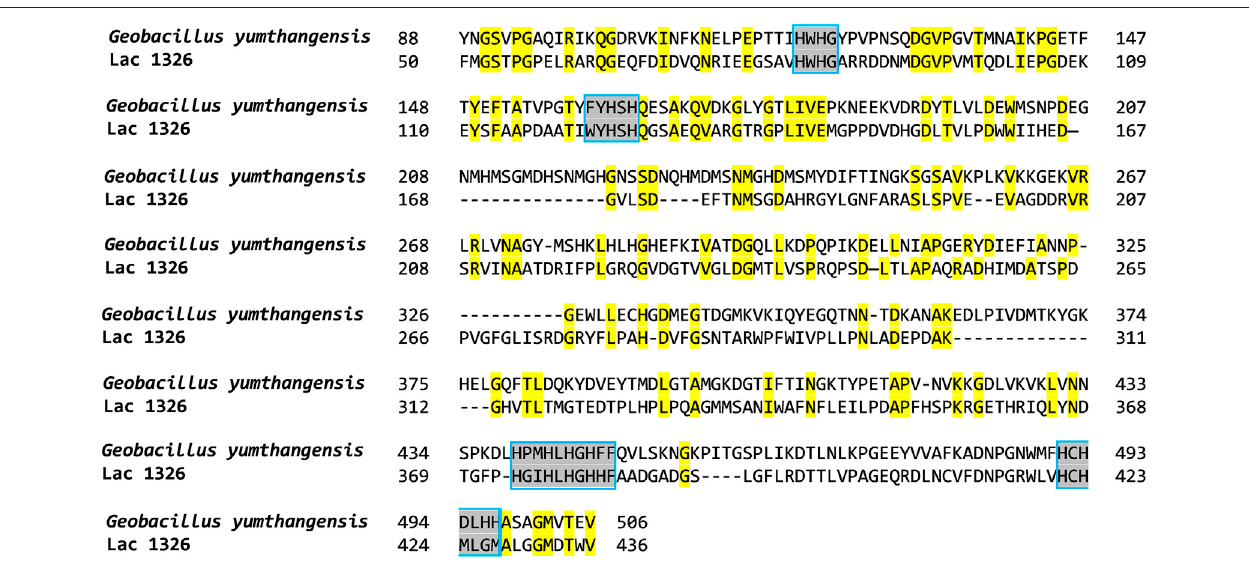
Frontiers in Chemistry |